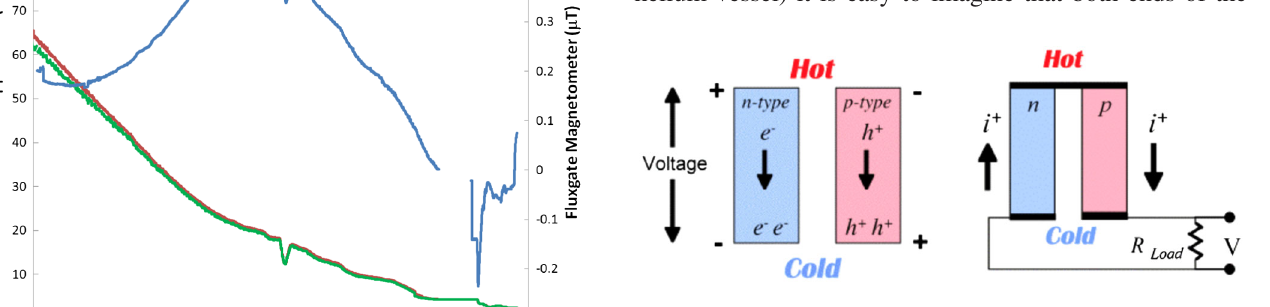
FIG. 2. Visualization of the Seebeck voltage of different metals (taken from [10]), not connected (left) and connected on one side (right). In the nonconnected case a static voltage builds up resulting in a vanishing current in the equilibrium. If a loop exist (connected scenario), a persistent current is excited even in the equilibrium state, driven by the temperature difference between both material